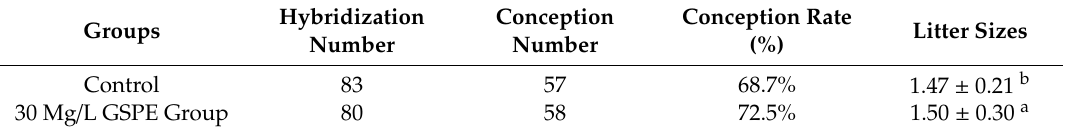
Table 5. Comparisons of pregnancy rates 30 days after artificial insemination (AI) using preserved